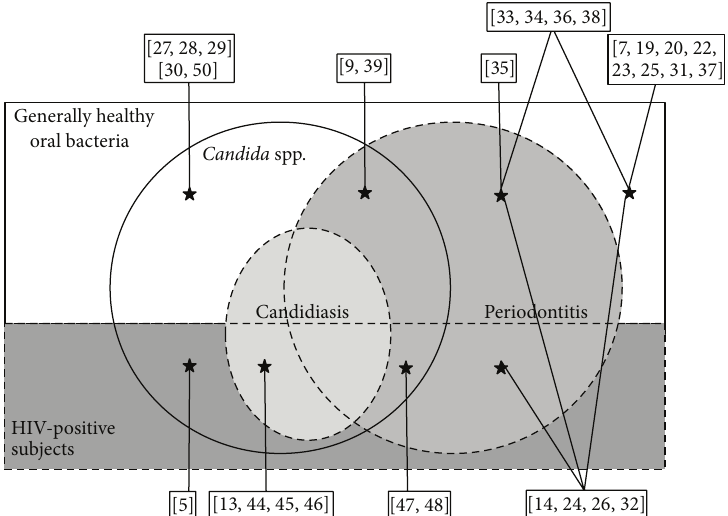
Figure 1: The microbiota and diseases described in the literature are cited in this review. The white background represents oral bacteria from generally healthy subjects. The dark grey background represents oral bacteria from HIV-positive subjects. The circle of Candida spp. represents detection of Candida spp. from oral bacteria in subjects. The light gray circle of candidiasis represents subjects with candidiasis. The gray circle of periodontitis represents subjects with periodontitis. Numbers in squares represent number of references cited in the text.